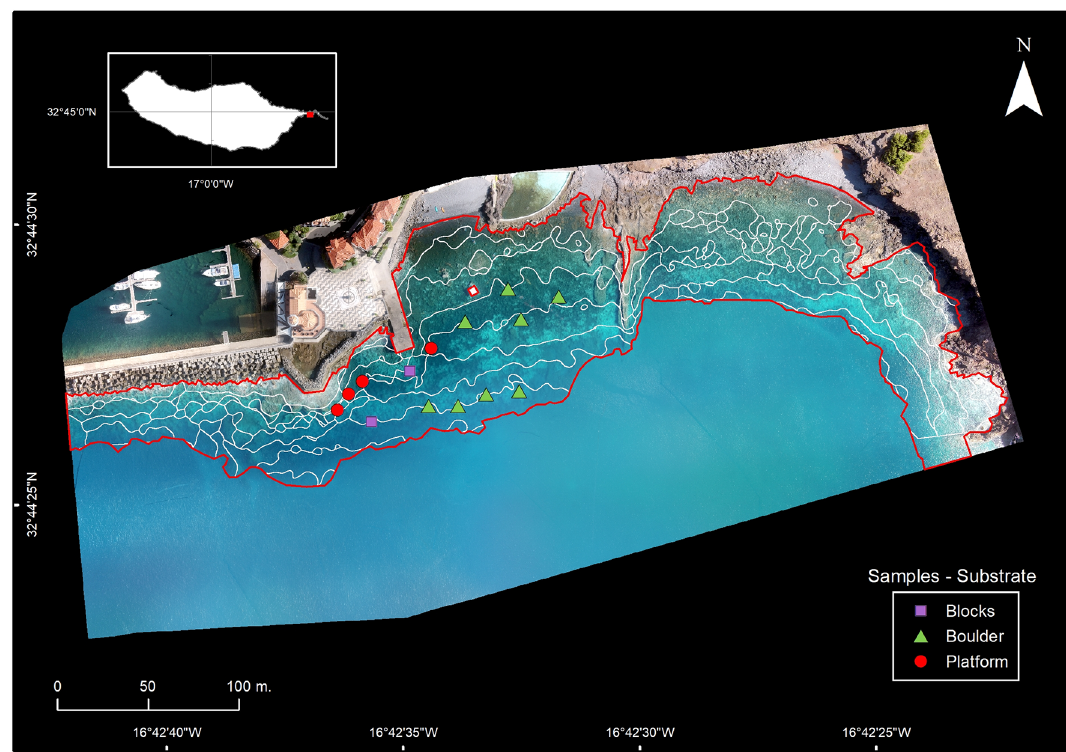
Figure 1. Ortho-photo mosaic of study area in Madeira island (location on top-left box) with discrete boundaries for depth classes (white contours) over assessment target area (red-contour) and location of underwater surveys (shape and colour indicate dominant substrate; bottom-right label box). Map and figure generated in ESRI ArcGIS Desktop